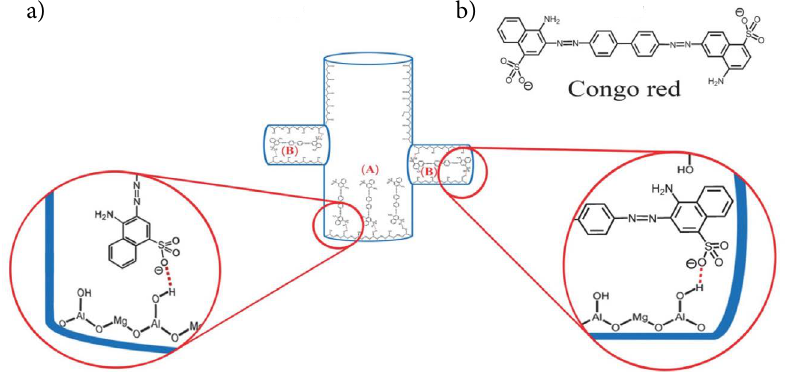
Figure 8. (a) Schematic representation of (A) MP and (B) 003 adsorption sites of Mg-Al-LDH and (b) CR molecule structure.